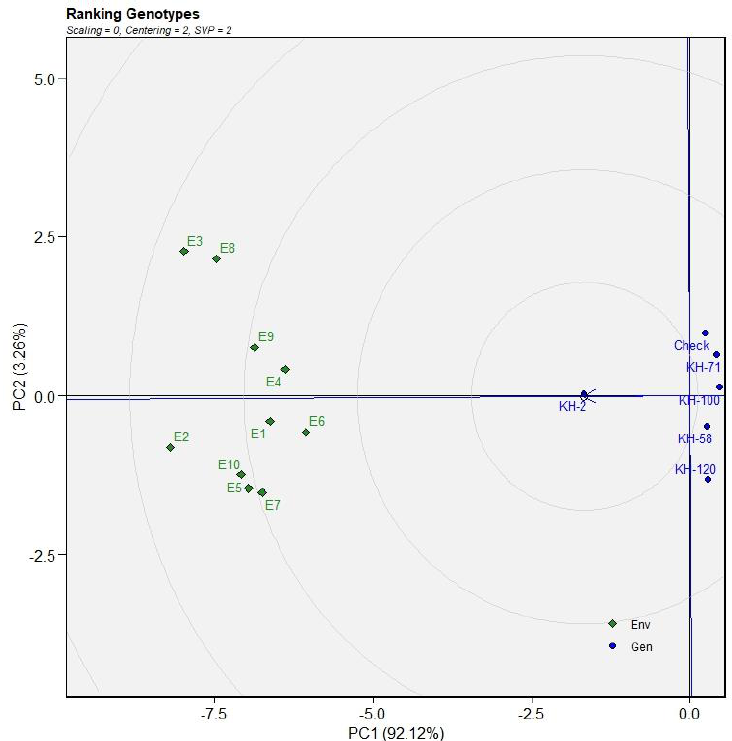
Figure 5 . The genotype ranking through GGE plots for FRY based on ideal genotype for eleven environments.